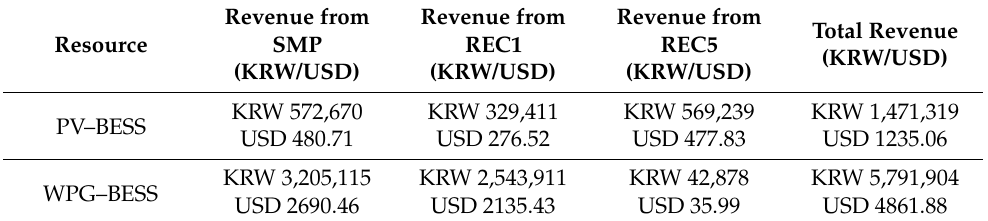
Table 9. Intraday revenue generated from the scheduling methods with profit maximization.